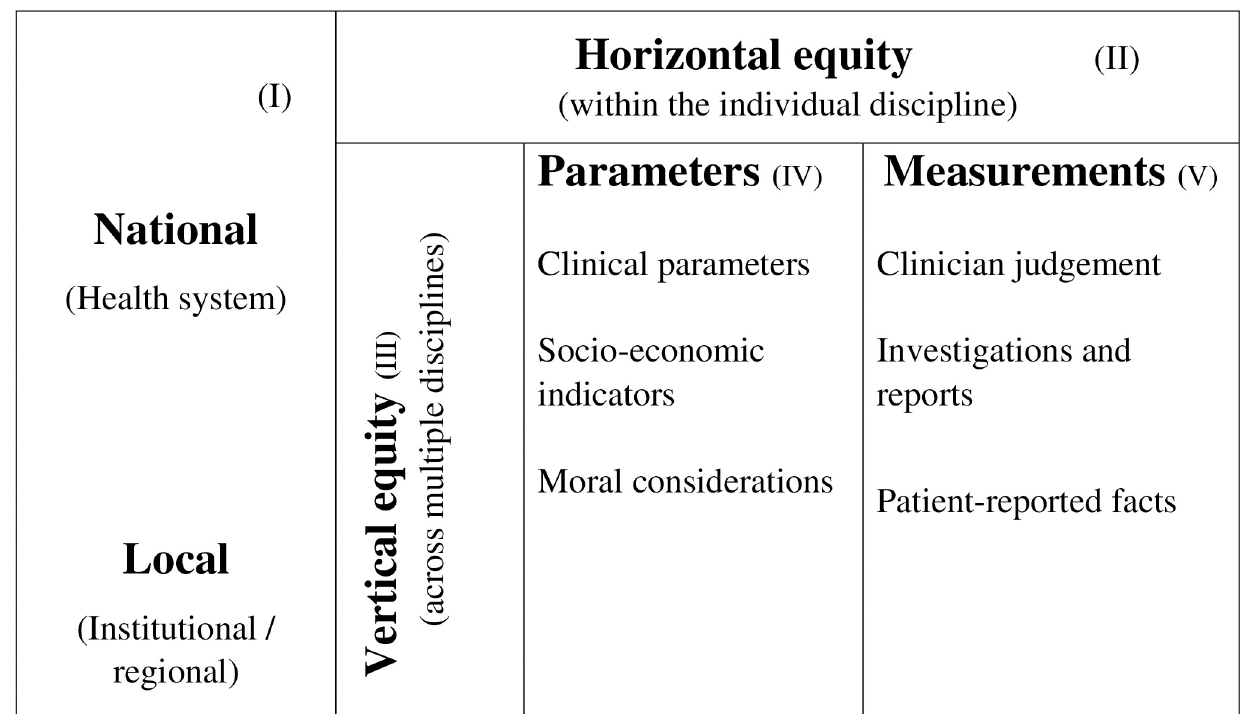
Fig 4. Framework for suggested parameters to be considered in an efficient patient prioritisation